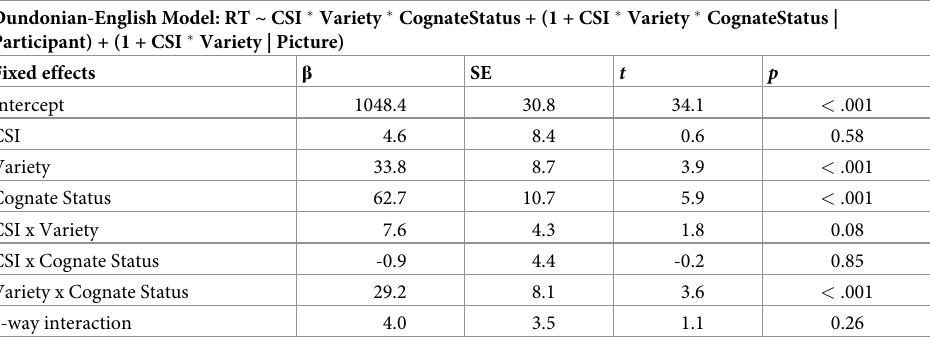
Table 3. Parameter estimates and results of significance tests in mixed-effects models for Experiment